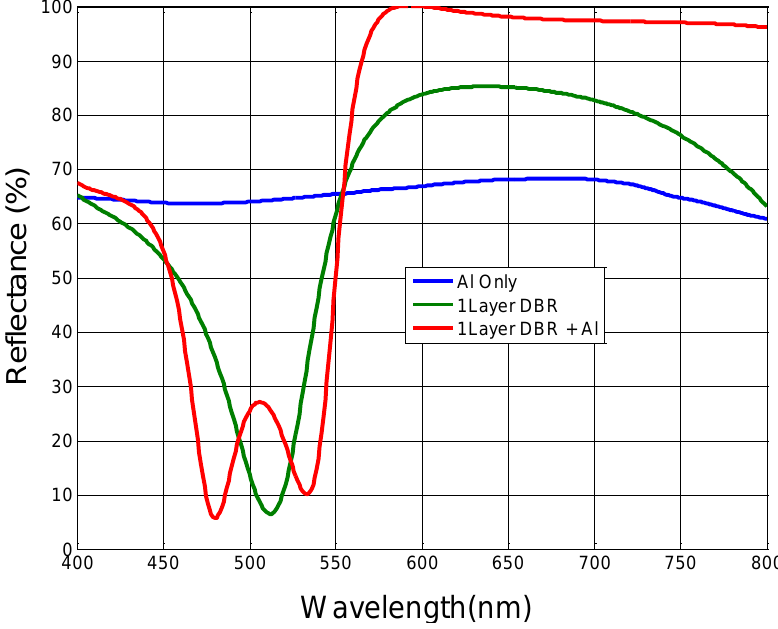
Figure 7. Reflectance characteristics of the 1 layer DBR structure (green plot), as compared to a structure of aluminum only (blue plot), and one with the 1 layer DBR plus an aluminum layer (red